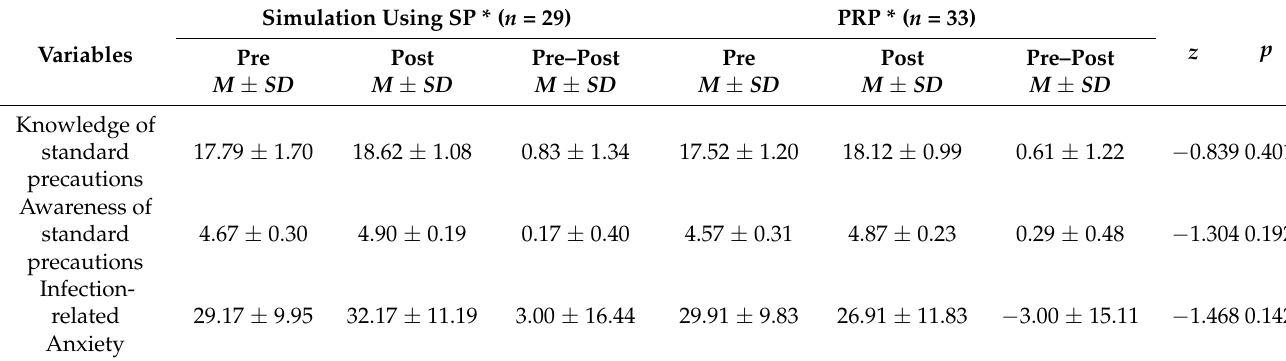
Table 4. Difference of variables between two